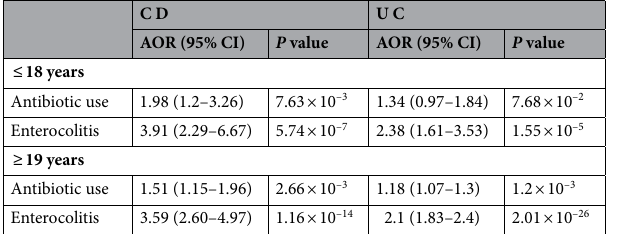
Table 6. AORs and 95% CIs using conditional logistic regression analysis for CD and